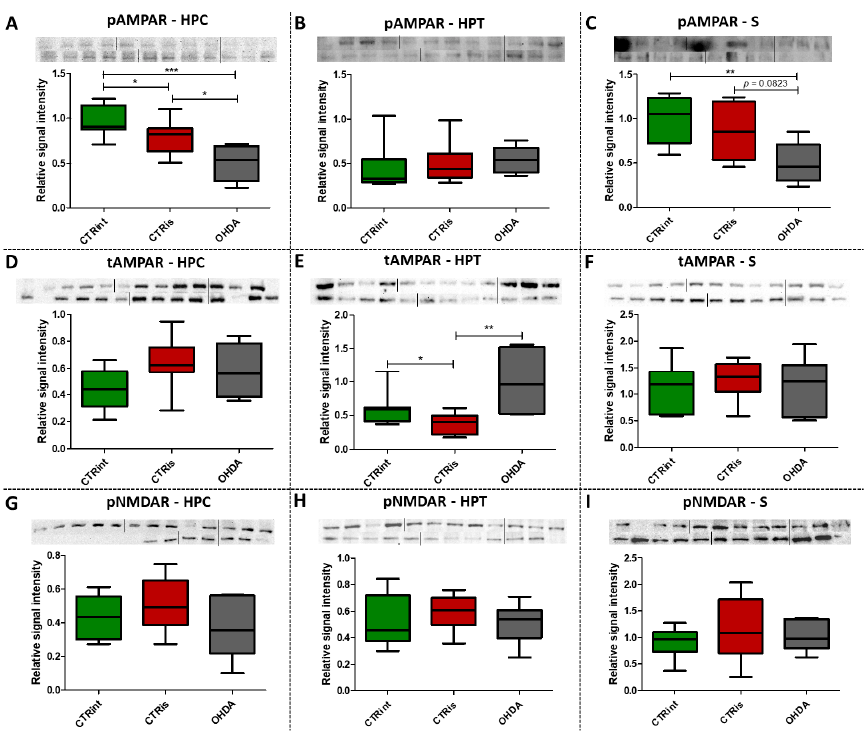
Figure 4. The effect of intrastriatal administration of 6 ‐ OHDA on levels of glutamate receptors. Protein levels of phosphorylated (pAMPAR; ( A – C )) and total AMPAR (tAMPAR; ( D – F )) receptors and levels of phosphorylated NMDAR receptors (pNMDAR; ( G – I )) were measured by Western blot in the brains of animals 3 months after intrastriatal administration of 6 ‐ OHDA (OHDA) or vehicle only (CTRis) and aged matched intact rats (CTRint). Western blot results in the hippocampus (HPC; A, ( D , G )), hypothalamus (HPT; ( B , E , H )) and striatum (S; ( C , F , I )) are represented as a box and whiskers (min to max) plot with between ‐ group differences tested by two ‐ tailed Kruskal–Wallis one ‐ way analysis of variance, followed by the Mann–Whitney U ‐ test, with p < 0.05 considered statistically significant (* p < 0.05, ** p < 0.01, *** p < 0.001). Corresponding Western blot images are presented above the plot. n (intact control/CTR) = 9, n (sham operated control/CTRis) = 9, n (OHDA) = 6.